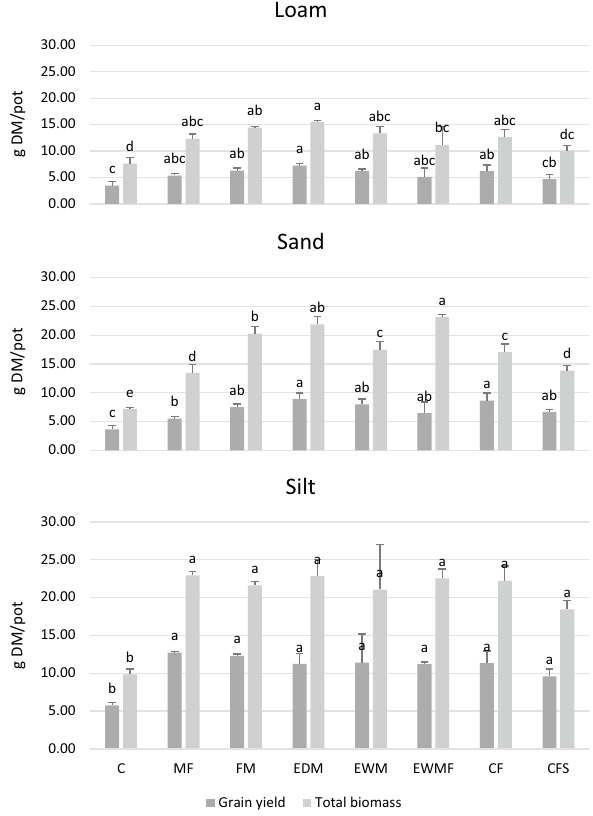
Fig. 1 Total biomass (g DM pot −1 ) and grain yield (g DM pot −1 ) in loam, sand and silt. The standard deviation within each treatment ( n = 3) is indicated by the line extending the column. Within each soil, significant differences are indicated by